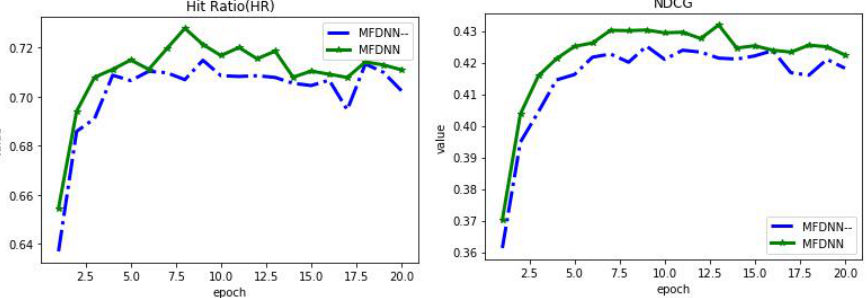
Figure 10. HR and NDCG values for MFDNN- - and